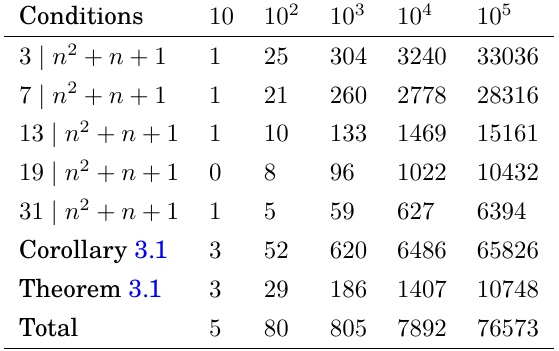
Table 1: The numbers of n to which Corollary 3.1 and Theorem 3.1 can be applied, where v = | G/H |